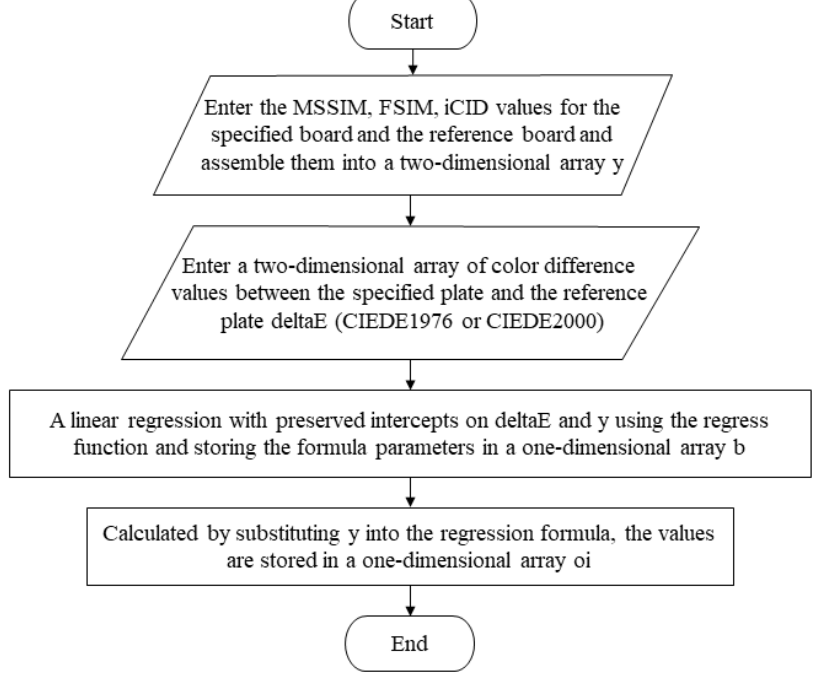
Figure 7. Compilation framework for the objective correlation algorithm.